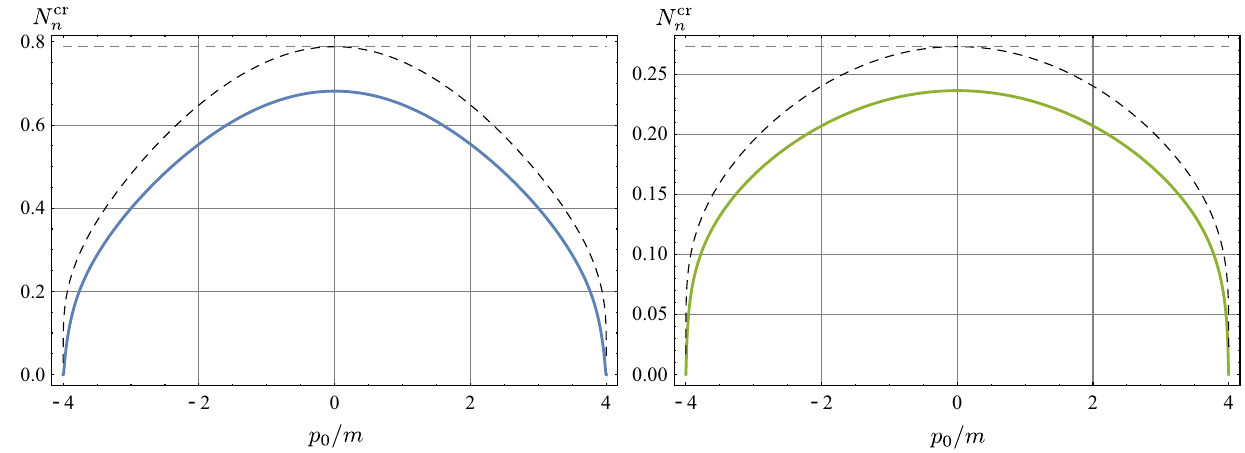
E = 500 E c and m ξ 1 = m ξ 2 = 1 / 100. The magnitude of the potential energy step is constant for both plots U / m = 5 = const . and so is the extension of the Klein zone, which is | p 0 | / m ≤ 4 . The horizontal dashed lines denote the maximum value